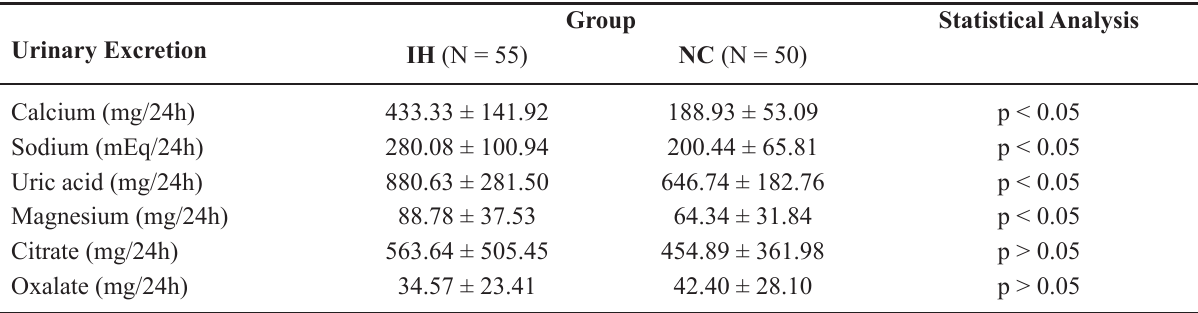
Table 2 – Description of median and standard deviation of biochemical characteristics of 24-hour urine in the different studied